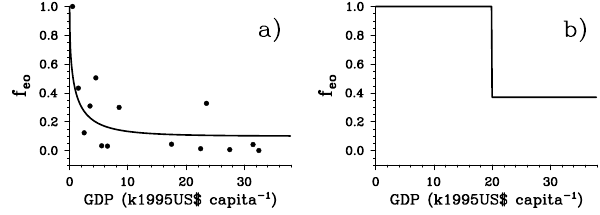
Fig. 5. Effect of economic situation on fire occurrence, f eo , for (a) grass and shrub PFTs and (b) tree PFTs (lines). In shrub- and grass- dominated regions (fractional coverage of shrub and grass PFTs > 50%), 2001–2004 average 0.5 ◦ MODIS fire counts are parti- tioned over 1k1995US$capita − 1 GDP bins. Black circles in (a) indicate the (normalized) average fire counts in bins with sam- ple size > 5. Goodness of fit is R 2 = 0 . 73 ( n = 14). f eo in (b) reproduces that the MODIS fire count in tree-dominated regions of GDP ≥ 20k1995US$capita − 1 is 0.39 of that in other tree- dominated